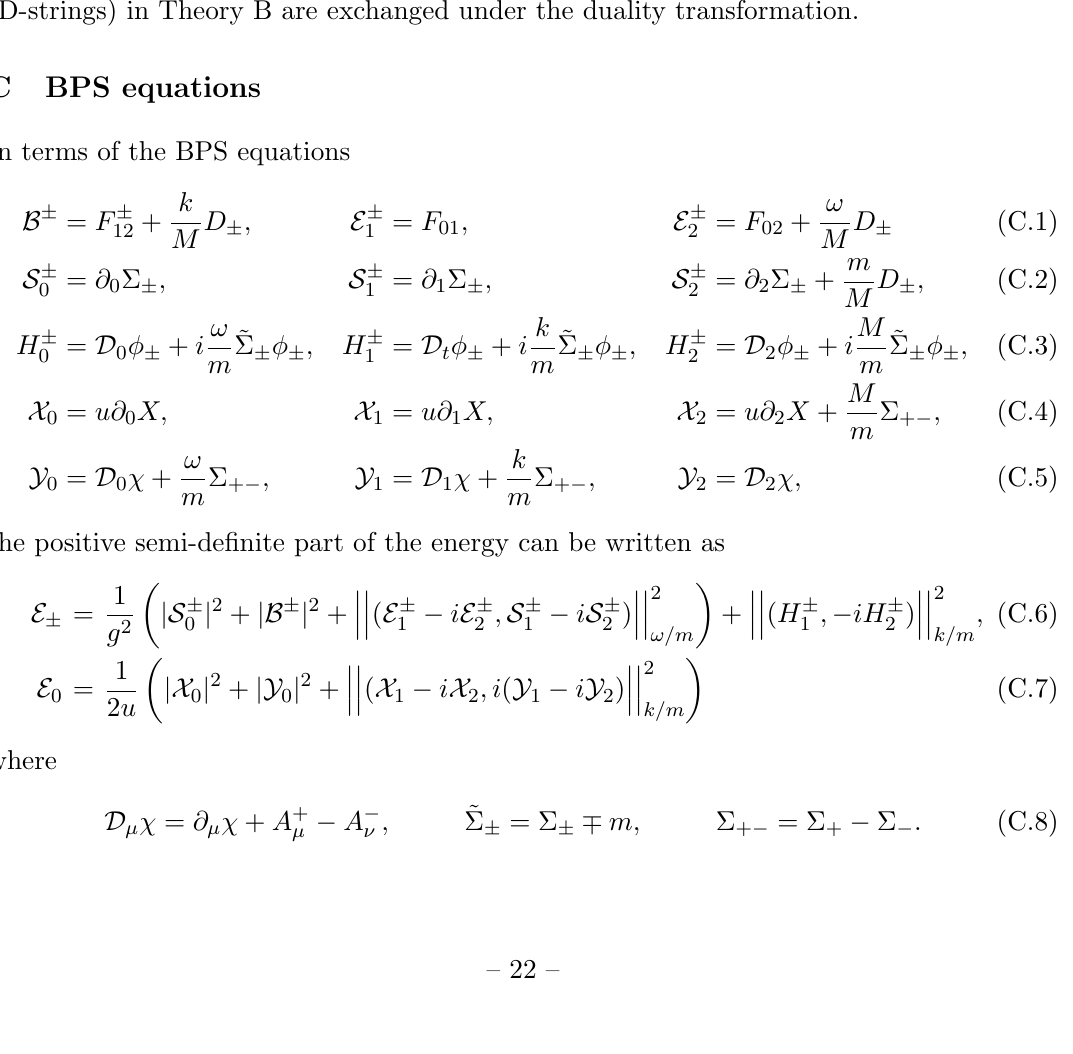
Figure 12 . BPS vortices (D-strings) and particles (F-strings) in Theory A and B ( N = 3). (see (cid:12)gure 12). Similarly, the hypermultiplets (F-strings) in Theory A and the vortices (D-strings) in Theory B are exchanged under the duality